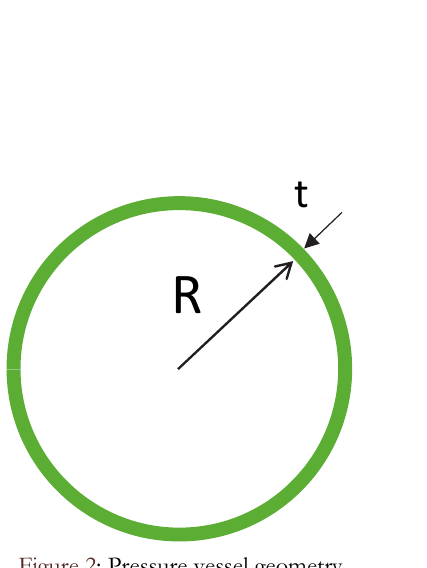
Figure 2: Pressure vessel